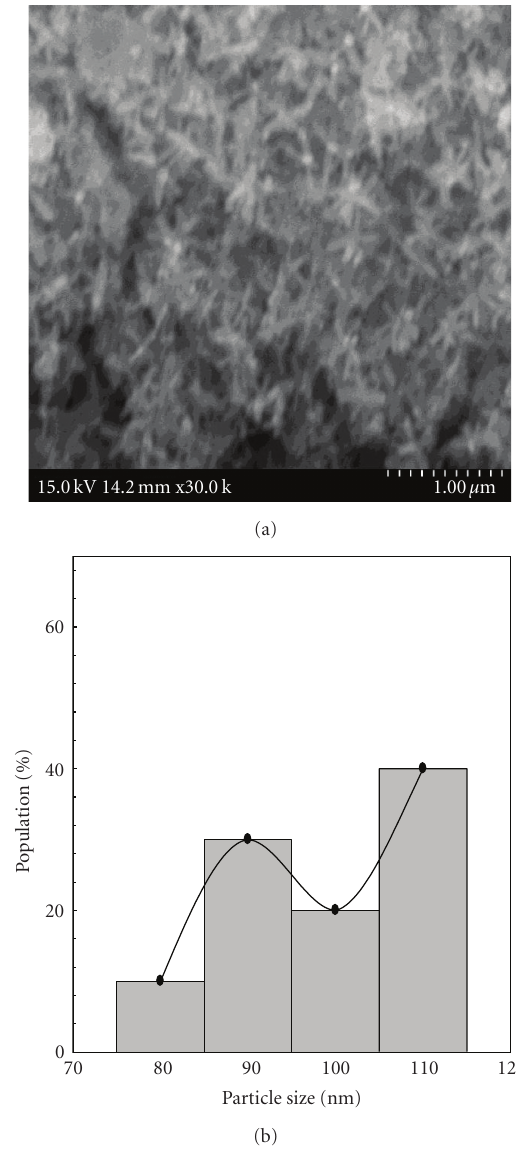
Figure 5: TiCI 4 -TiO 2 thin film morphology after annealing at 500 ◦